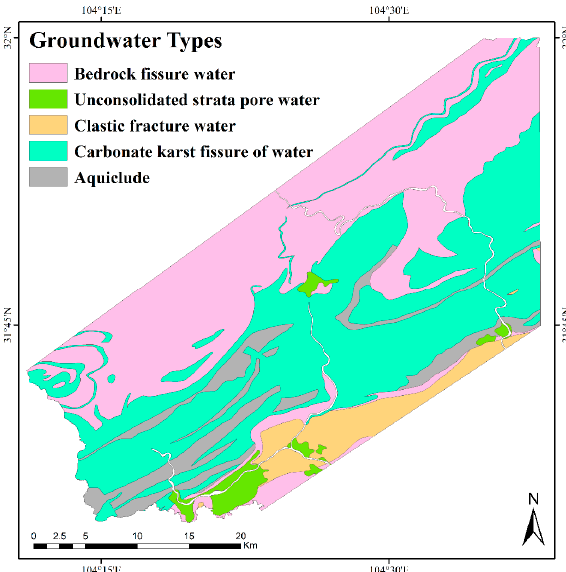
Figure 3. Groundwater types in the study area.